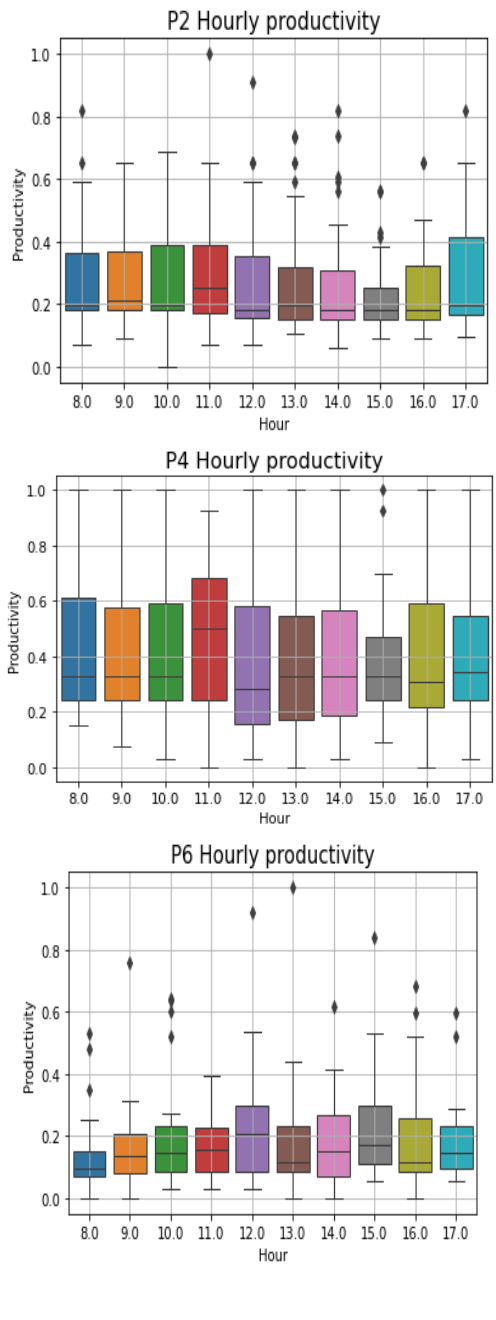
Figure 21. ( a ) Hourly productivities I. ( b ) Hourly variation in productivities.